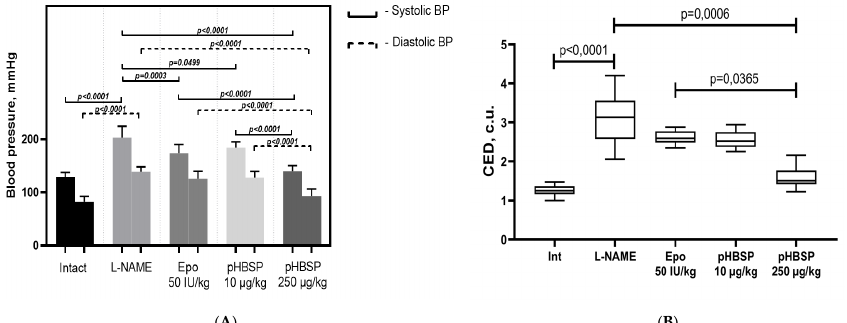
Figure 1. The effect of pHBSP on the blood pressure ( A ) and the coefficient of endothelial dysfunction ( B ) in animals with ADMA-like preeclampsia. Note: SBP, DBP – n = 10 animals in each group, systolic and diastolic blood pressure (mmHg); CED-coefficient of endothelial dysfunction (relative units, R.U.).